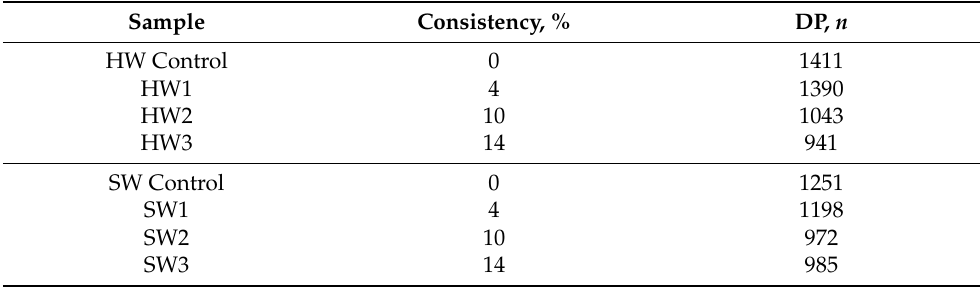
Table 3. Determination of the degree of polymerization (DP) for oxidized pulps.